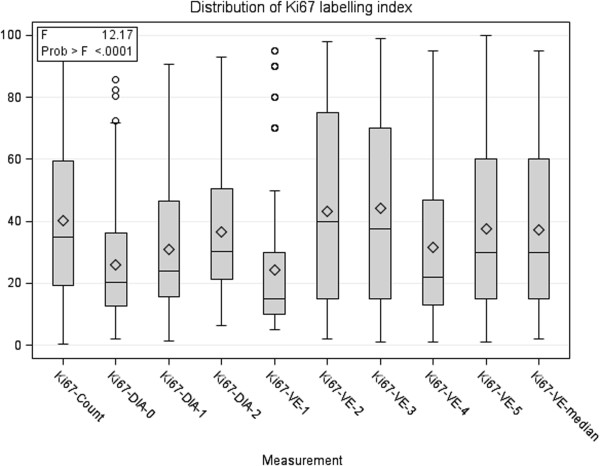
One-way ANOVA box and whisker plot of the distribution of Ki67 labelling index by the method of measurement (n = 164).